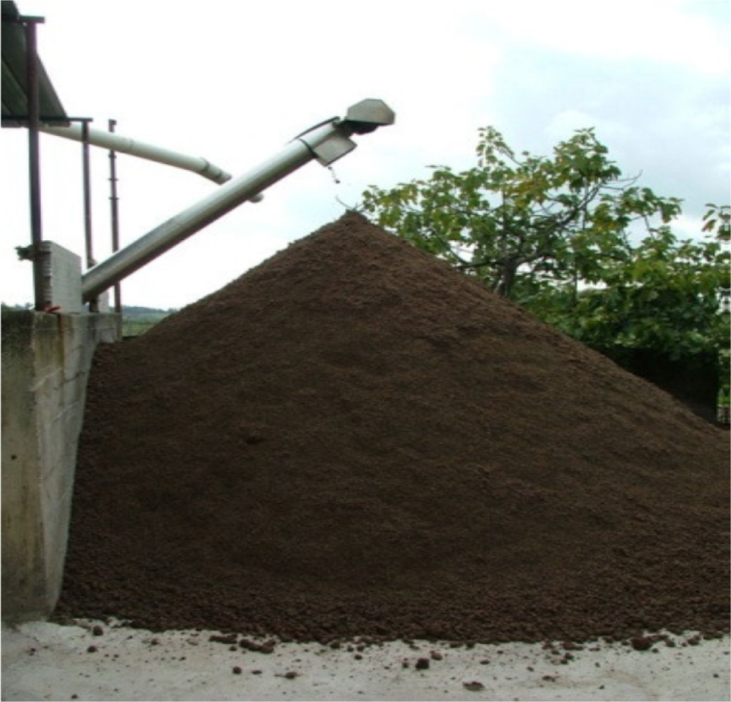
Olive pomac/cake.